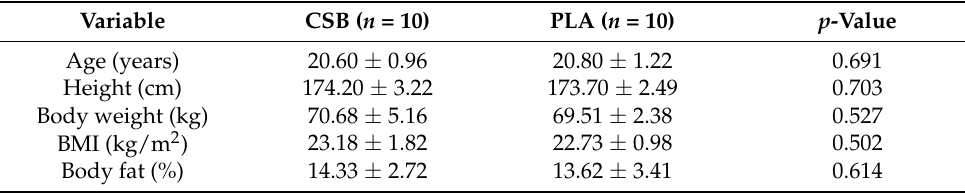
Table 1. Physical characteristics of